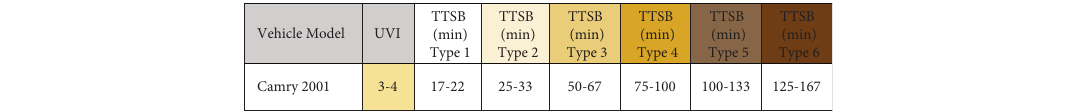
Table 5: Transmitted UVI through a Toyota Camry model 2001 vehicle, and the corresponding time to sunburn for skin types 1 to 6. Vehicle